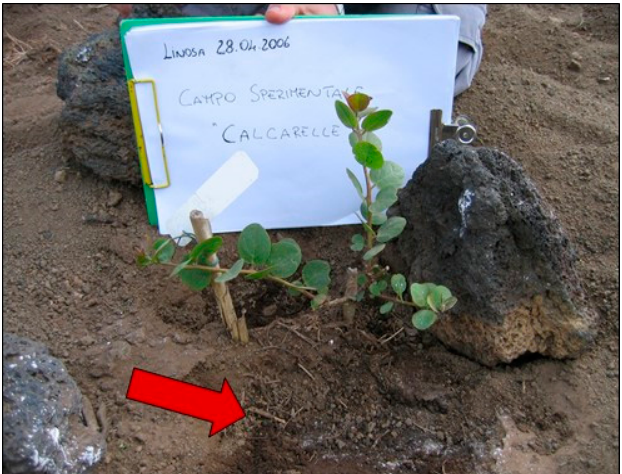
Figure 1. Mitigating effect on evaporation of the lava stones.